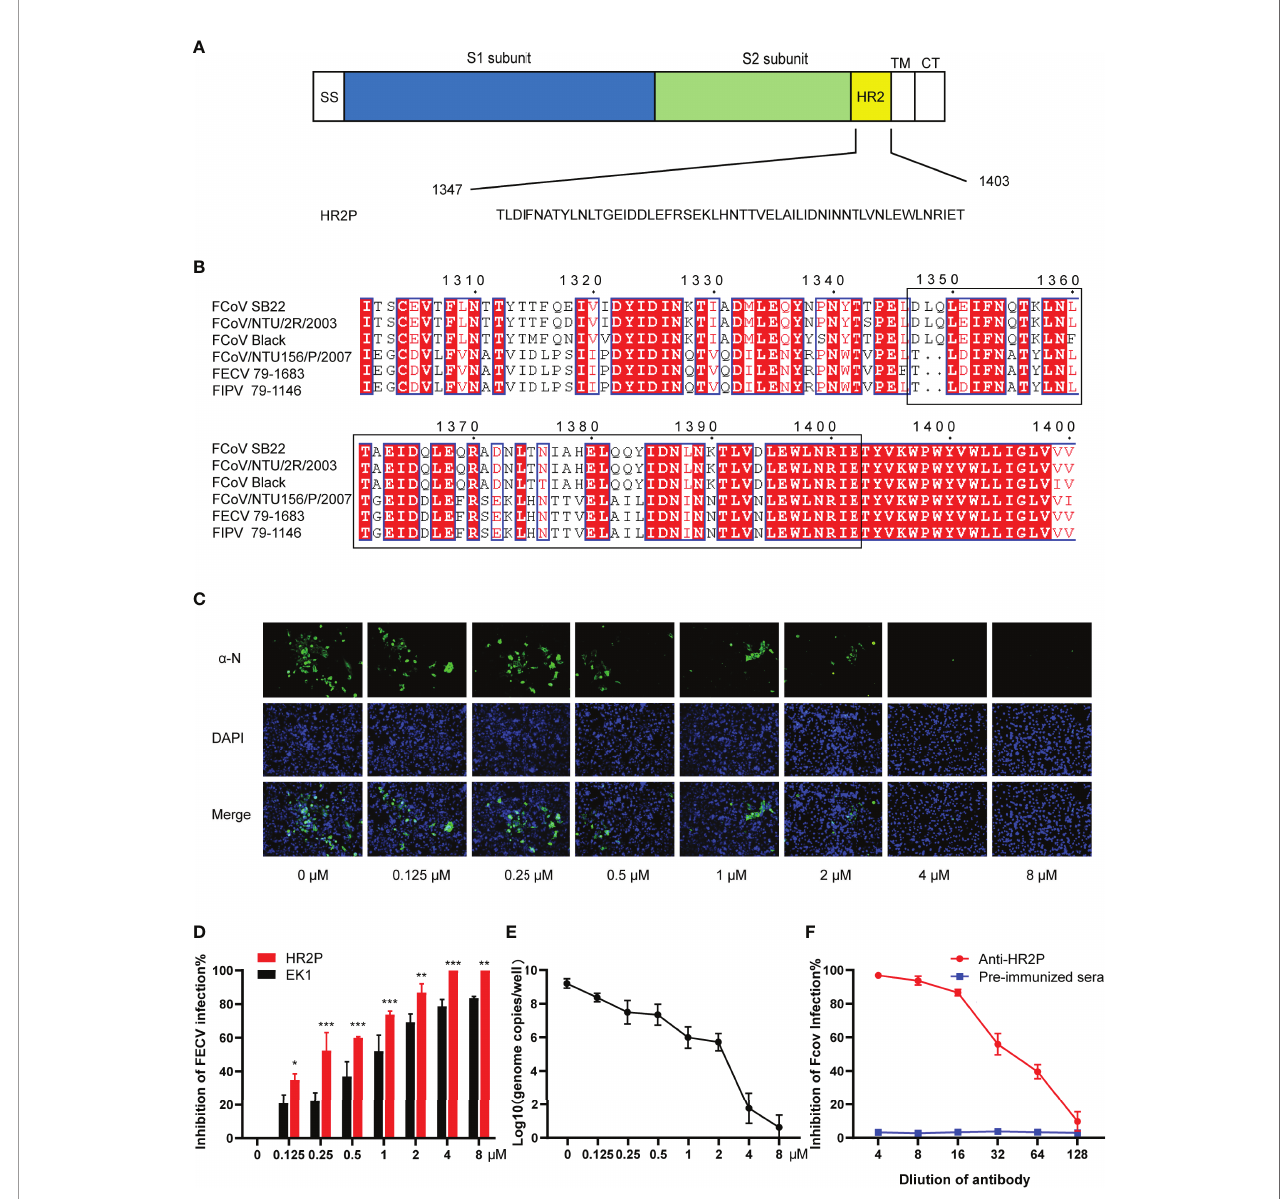
FIGURE 1 | The FECV spike HR2 peptide (HR2P) exhibits antiviral activity and elicits neutralizing antibodies. (A) Schematic of the S glycoprotein, showing heptad repeat 2 (HR2) located within the S2 subunit. Other domains shown include SS (signal sequence), TM (transmembrane domain), and CT (cytoplasmic tail). The HR2 sequence was predicted by the LearnCoil-VMF program. (B) Multiple sequence alignment of HR2 regions (1347-1403 aa based on the FECV strain 79-1683) from type I (FCoV-SB22, GenBank accession no. MH817484; FCoV/NTU/2R/2003, DQ160294; FCoV Black, EU186072) and type II (FCoV/NTU156/P/2007, GQ152141.1; FECV 79-1683, X80799.1; FIPV 79-1146, DQ010921.1) strains by using ClustalX1.8 and ESPript3.1 program. Residues highlighted in red are completely conserved. (C) Inhibition of FECV infection by HR2P in vitro . FECV (MOI = 0.01) was preincubated with soluble HR2P-His at various concentrations (0.125, 0.25, 0.5, 1, 2, 4, and 8 m M) for 1 h at 37°C, and then used to infect CRFK cells. Viral infection was determined at 24 hpi by IFA, using a polyclonal antibody against the viral N protein, followed by incubation with a FITC-conjugated secondary antibody. (D) Comparison of peptide (HR2P and EK1) inhibition of FECV infection. Figure represents mean ± standard error of triplicate wells; * P <.05; ** P <.01 ; *** P <005. (E) Infection of FECV in CRFK cells was inhibited by HR2P-His at various concentrations (0.125, 0.25, 0.5, 1, 2, 4, and 8 m M) within 24 h. FECV RNA titers were measured by qRT-PCR targeting the 3 ′ -UTR. * P <.05; ** P <.01 ; *** P <005. (F) Neutralizing activity of polyclonal antiserum raised against HR2P. FECV (100 TCID 50 /well) was preincubated with different dilutions of antiserum and used to infect CRFK cells, and the reduction in viral titer was quanti fi ed. The fi gure represents mean values from three independent experiments, and the error bars indicate the standard deviation. The fi gure represents the mean ± standard error of triplicate wells; * P <.05; ** P <.01 ; *** P